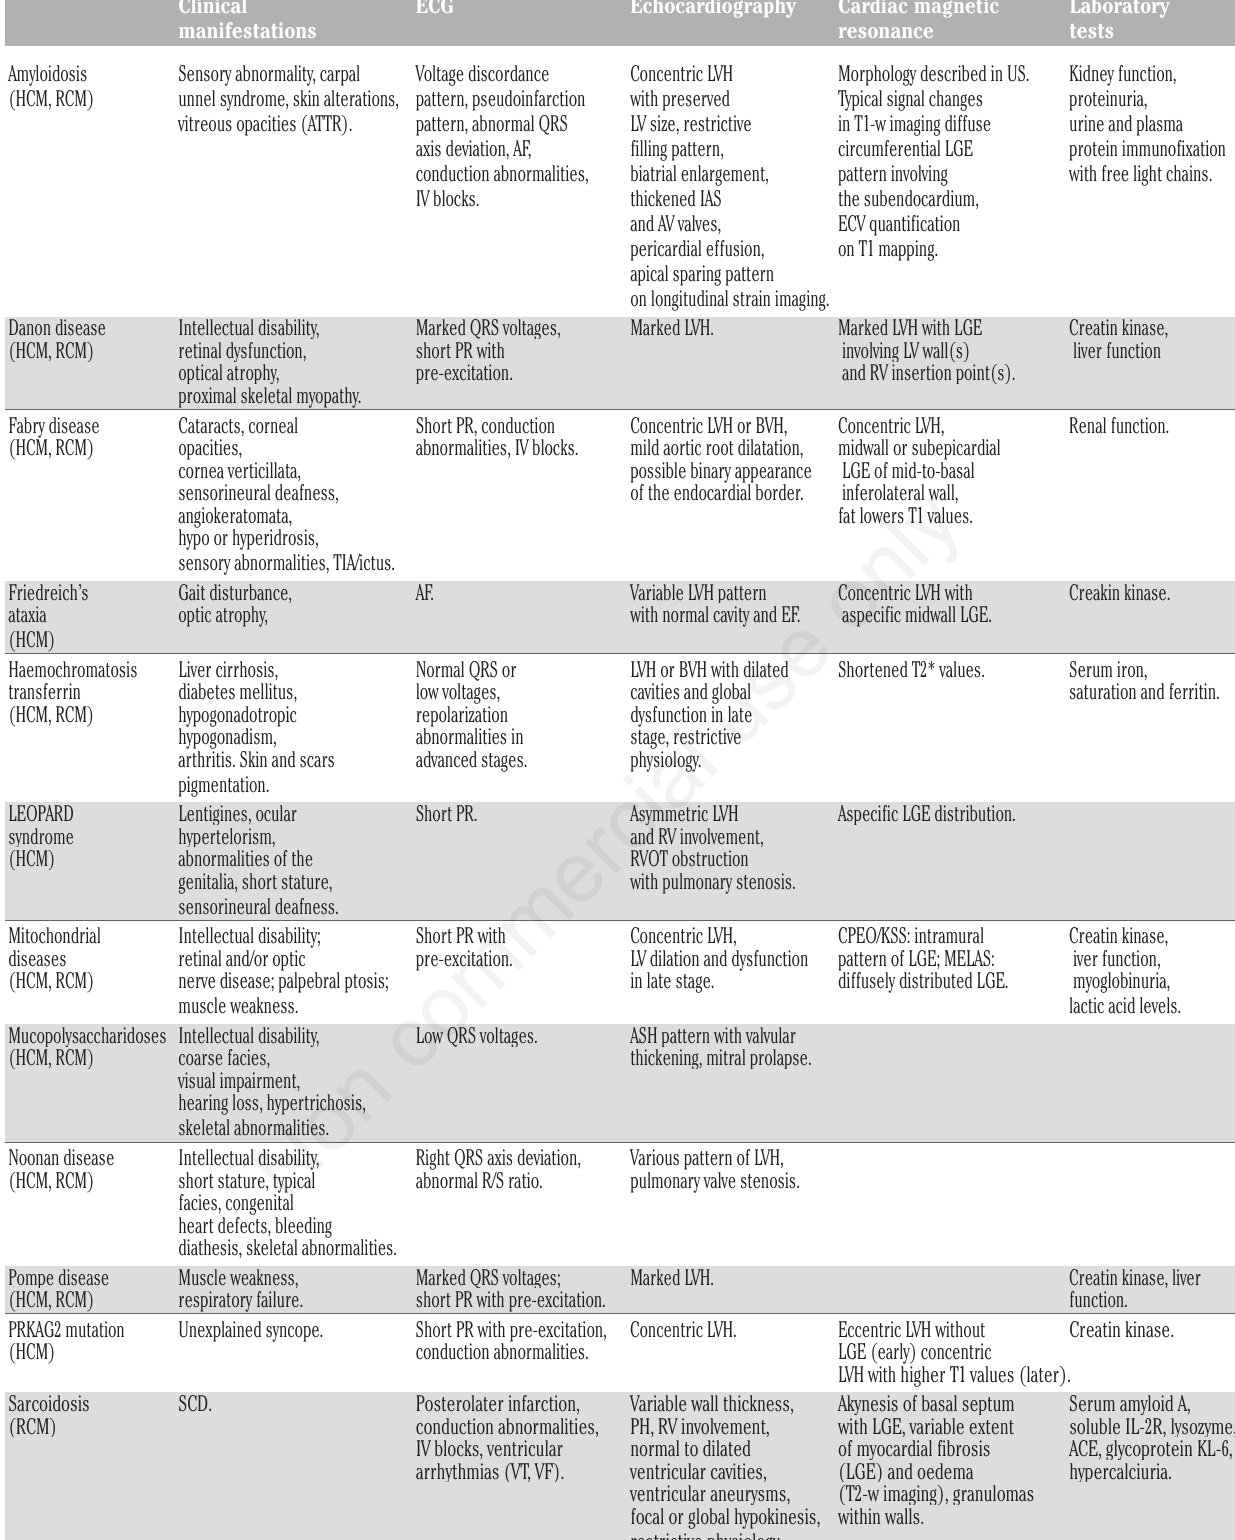
Table 1. Diagnostic clues fostering the suspicion of specific causes of hypertrophic and restrictive